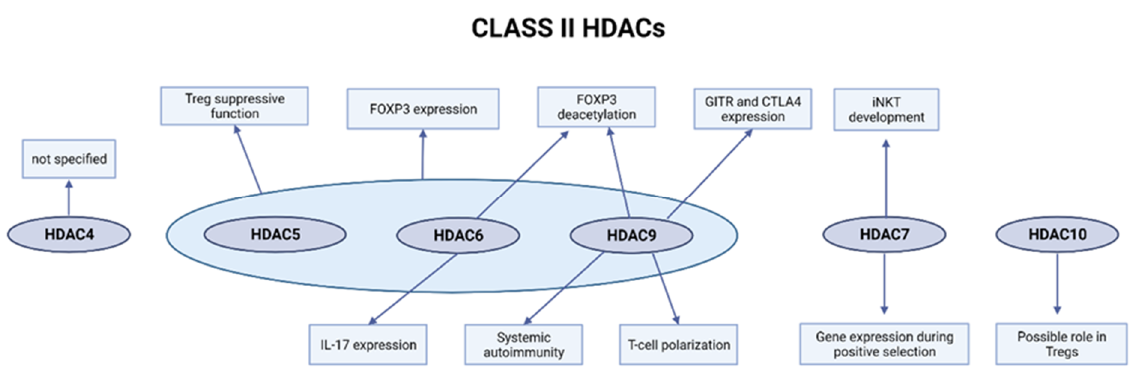
Figure 2. Role of class II HDACs in T-cells. Created with BioRender.